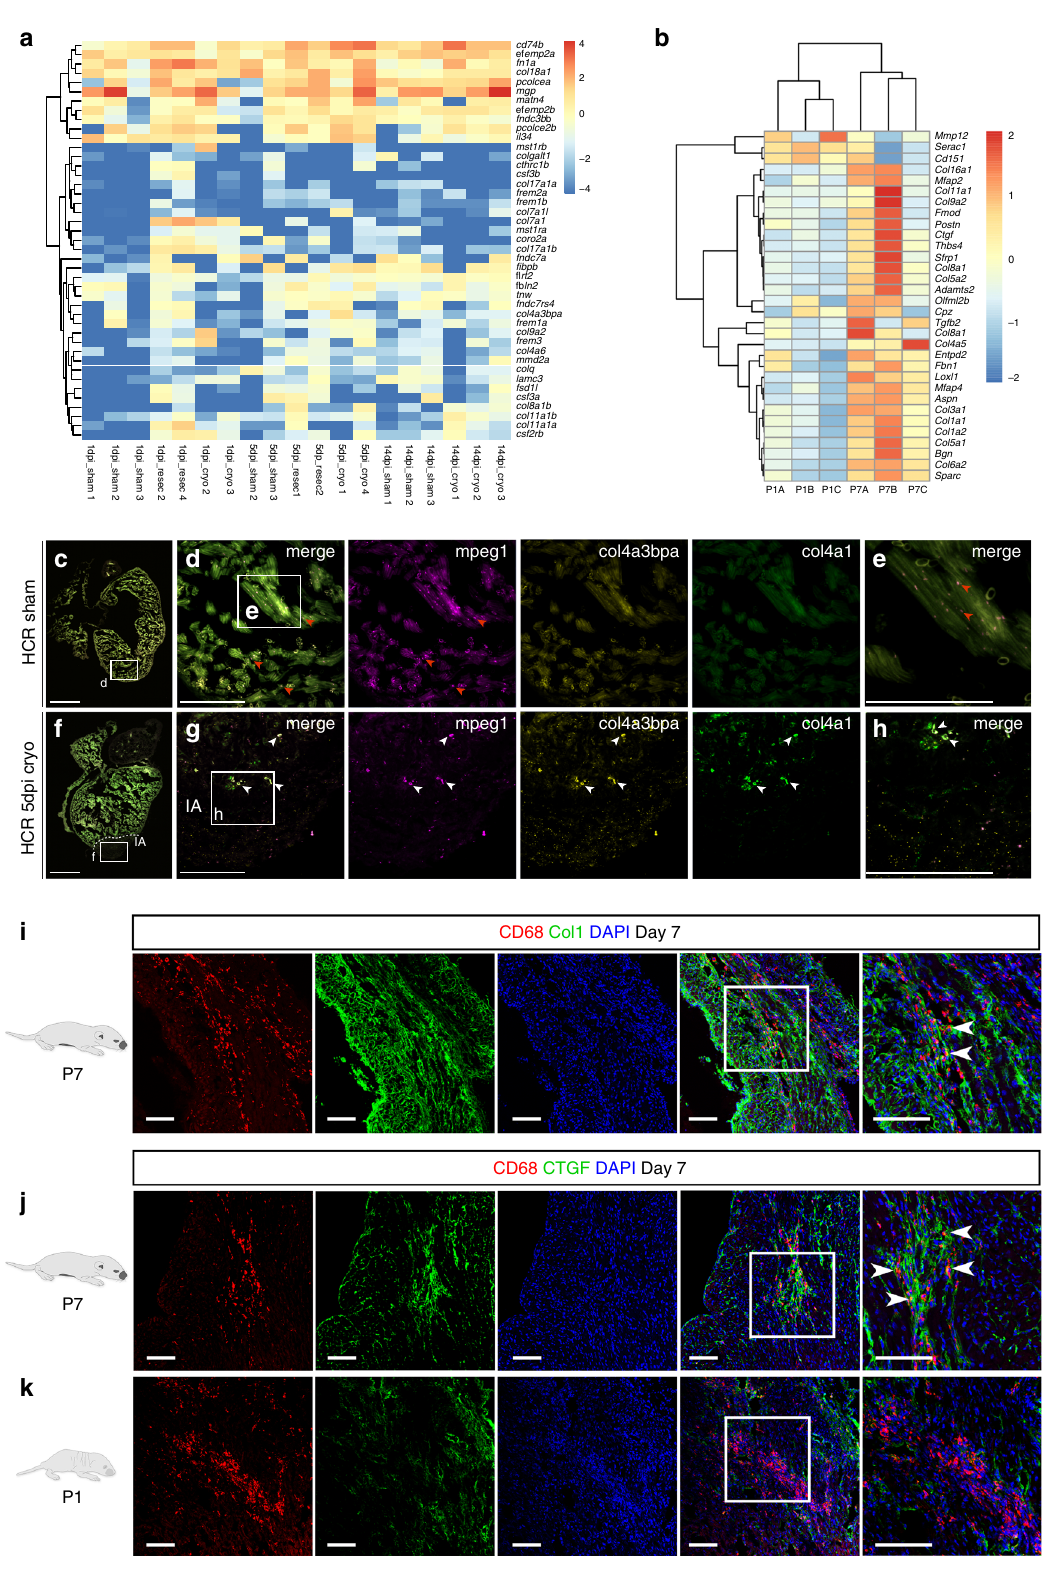
(scar-inducing) heart. We performed ventricular resection injury in Tg(mpeg1:EGFP) gl22 transgenic zebra fi sh which report macro- phages via GFP + fl uorescence 38 . GFP + macrophages were isolated 1 day post resection from adult hearts by FACS (Supplementary Fig. 8b), and transferred into a cryoinjured wild type (WT) zebra fi sh heart, at 1 dpi by retro-orbital injection 39